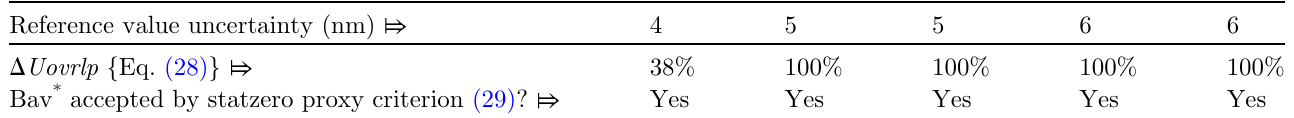
Table 11. Example 5 results (FAC-1, system C). Overlap of the con fi dence interval ★ with uncertainty of the reference , {Eq. (28)}). values ( D U ovrlp